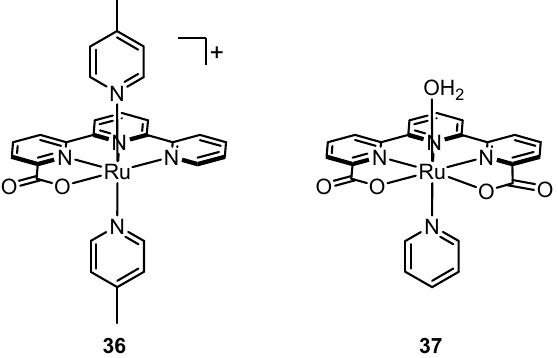
Molecules 2019 , 24 , x Figure 18. Proposed mechanism of water oxidation by [Ru II (tda- κ 4 -N 3 O)(py)] ( 35 ). Figure 18. Proposed mechanism of water oxidation by [Ru